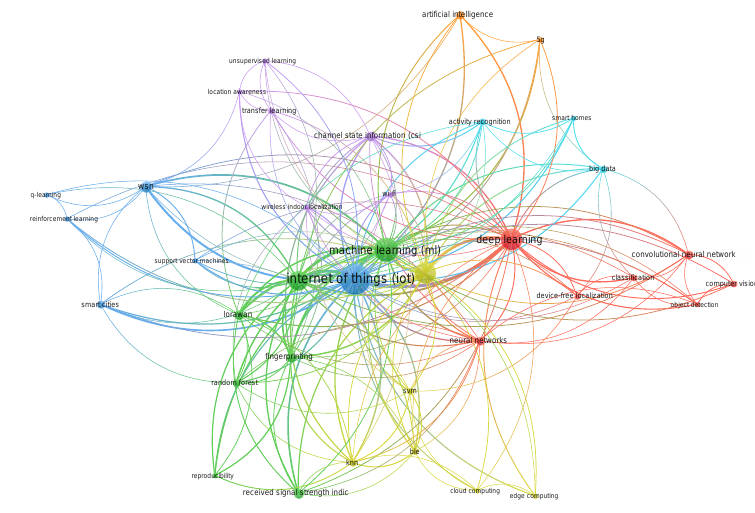
Figure 2. The keyword diagram on the Scopus database search results. This diagram depicts